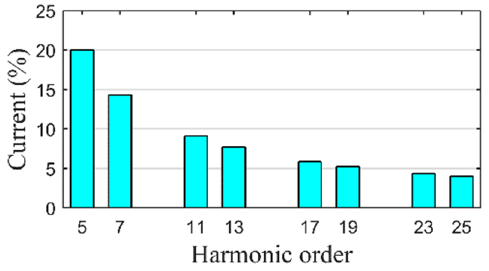
Figure 6. Harmonic spectra of six-pulse converter [2]. Table 1. Data of Nonlinear Load Power.